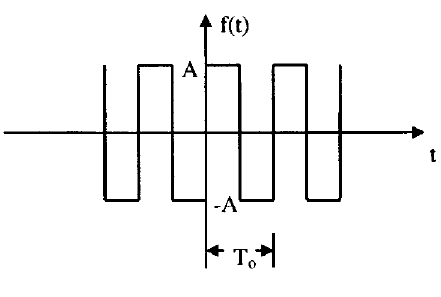
FIGURE 18 Periodic binary input signal.